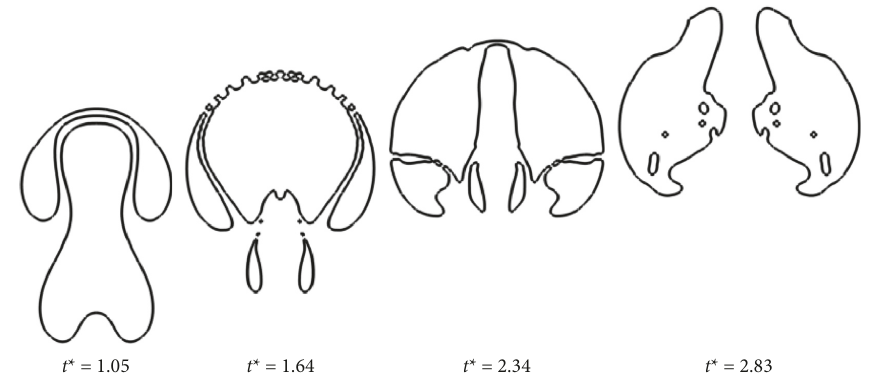
Figure 7: Coalescence process between two bubbles at Bo � 200, Ar � 200, ρ